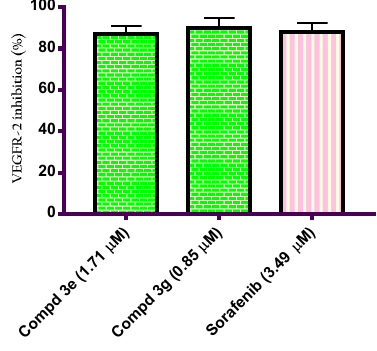
Figure 2. Graphical representation of the in vitro VEGFR-2 kinase inhibition activity (%) in NCI-H460 cells treated with benzimidazole molecules 3e and 3g and Sorafenib at their IC 50 concentration ( μ M).